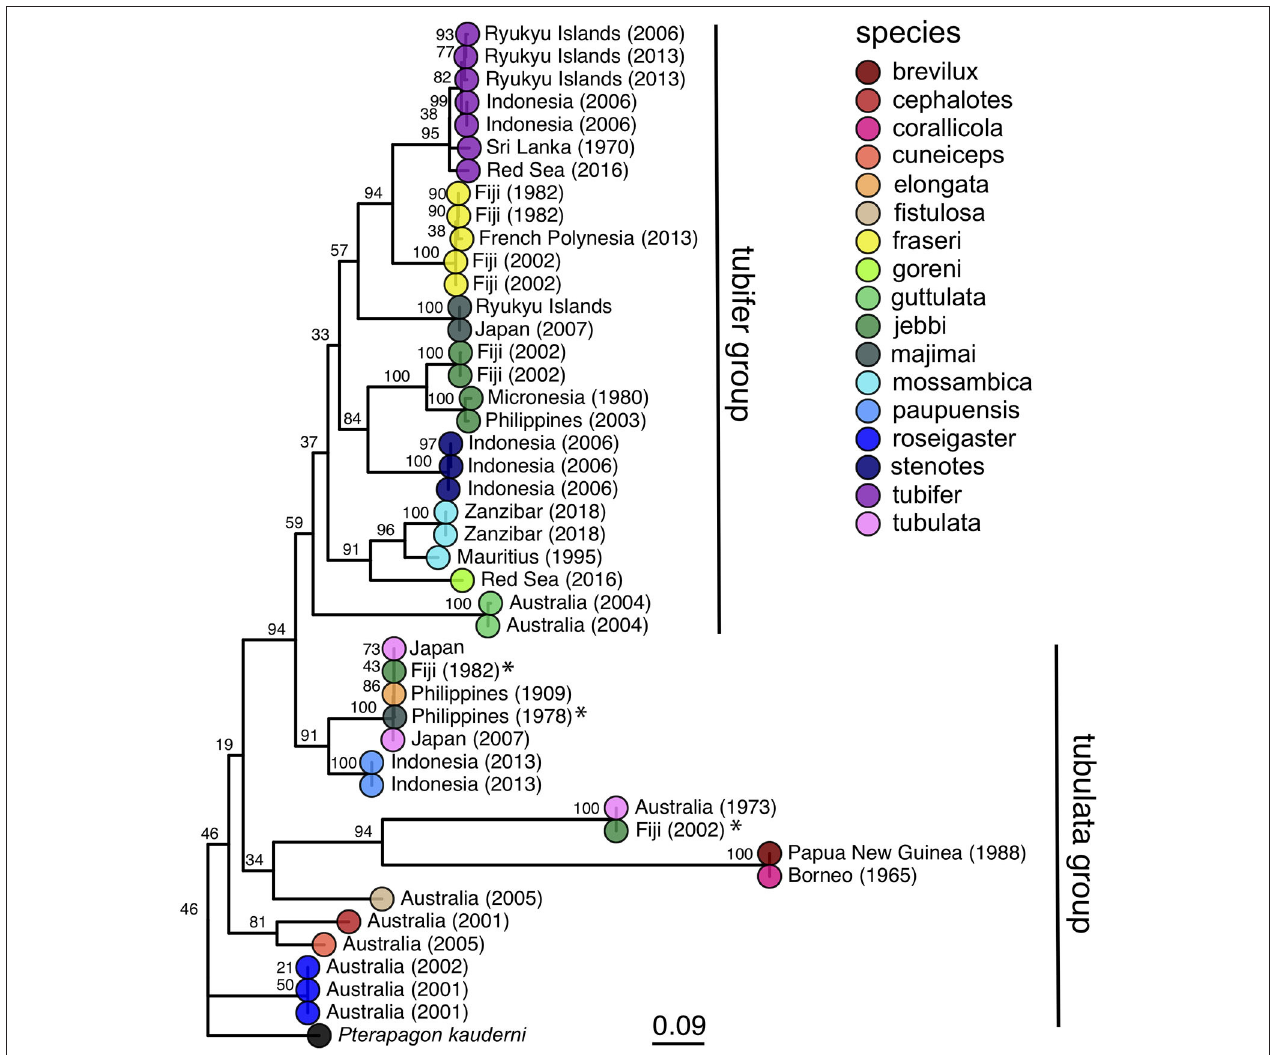
FIGURE 3 | Maximum likelihood phylogeny of cardinalfishes in the genus Siphamia based on COI gene sequences. Species identities are indicated by the branch tip colors and the sampling location and year of each specimen is listed in the branch label. Bootstrap support values are indicated at each node. The Banggai cardinalfish, Pterapogon kauderni, was used as the outgroup. The tubifer and tubulata subgroups within Siphamia (Gon and Allen, 2012) are highlighted with vertical lines to the right of the tree. Specimens that fall outside of their designated subgroup based on species identities are indicated with an